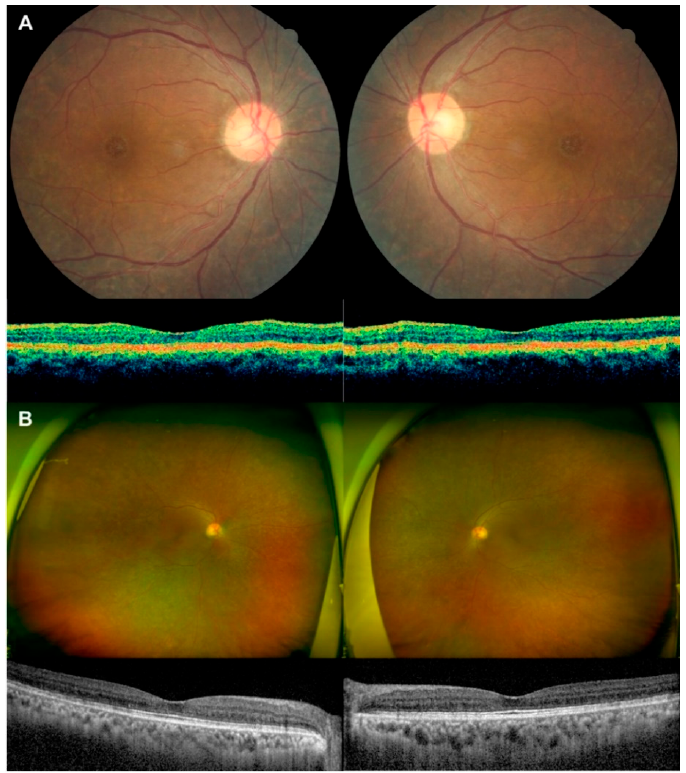
Figure 6. Images of the patient’s mother (a 63-year-old female): ( A ) fundus photograph and optical coherence tomography (OCT) at initial visit. Fundus photograph shows intact macular area